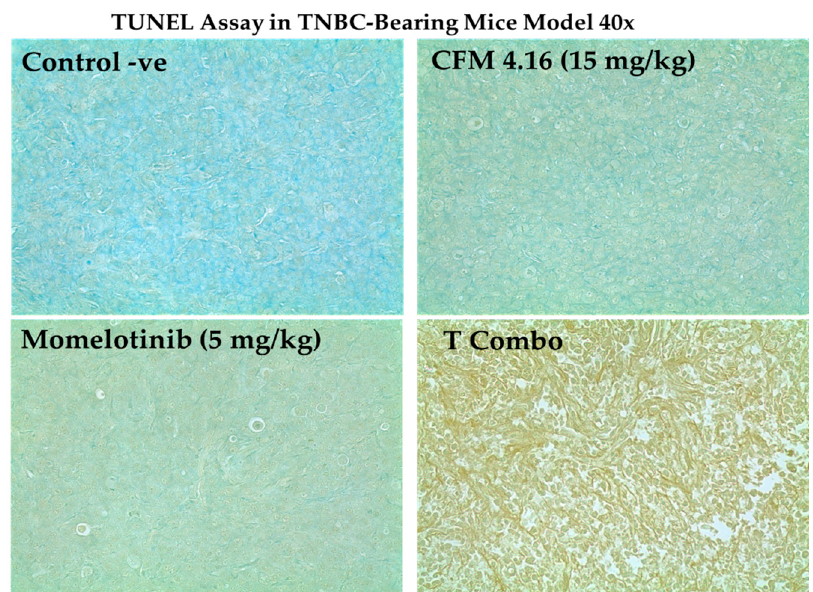
Figure 13. The capability of T combo to enhance the onset of apoptosis in TNBC- bearing mice by CD44. HA mediated endocytosis. T combo was able to drive the tumor to the late-stage apoptosis, which is based on generating multiple DNA double-strand breaks (DSBs) with accessible 3’-hydroxyl (3’-OH) groups that were detected by TUNEL. Elevated apopto- sis is indicated by brownish discoloration or dark brown spots. Note: T combo (CD44-T-PNPs+MMB) where MMB means momelotinib. Magnification is 40×.